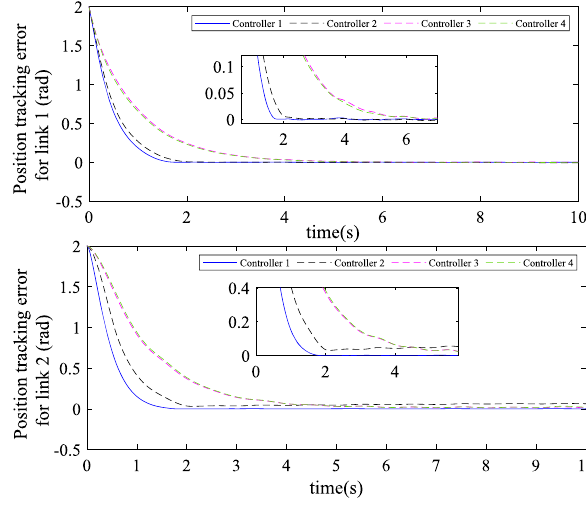
Fig. 2 Error convergence curve